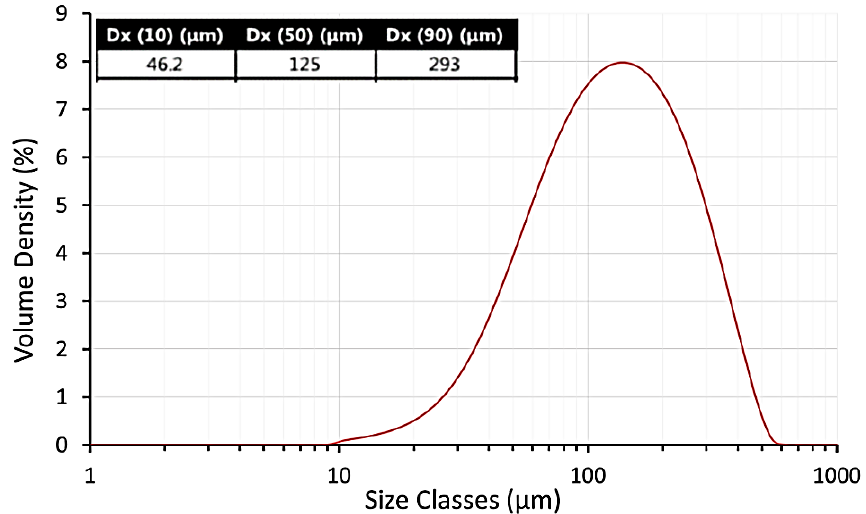
Figure 4. Particle size distribution of ultra-high molecular weight polyethylene (UHMWPE GUR 2122) powder.